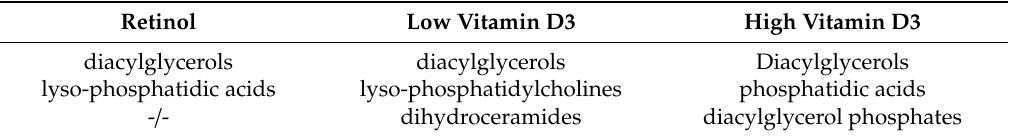
Table 3. Significantly increased cell membrane constituents upon treatment of HaCaT cells with Al 2 O 3 NMs divided by the additional treatment of either retinol low or high vitamin